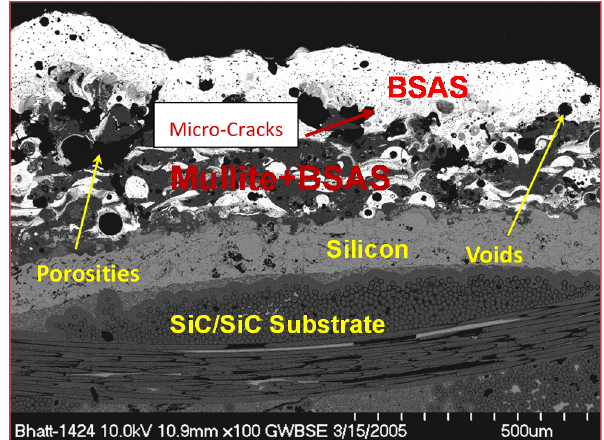
Figure 7. SEM photograph of the cross ‐ section of a typical plasma sprayed EBC on SiC/SiC composite specimen showing different layers of EBC and EBC layer microstructures.